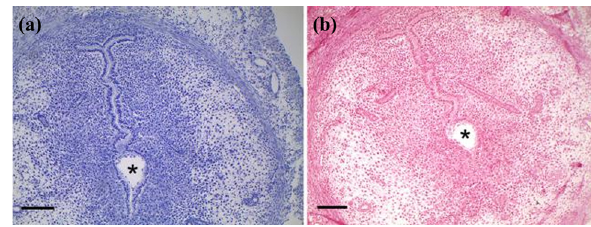
Figure 4: Mouse uteri of early pregnancy on day 5 stained with TB ( a ) and XP ( b ) . * = embryo. 100 × fi nal magni fi cation. Bar = 60 µm.